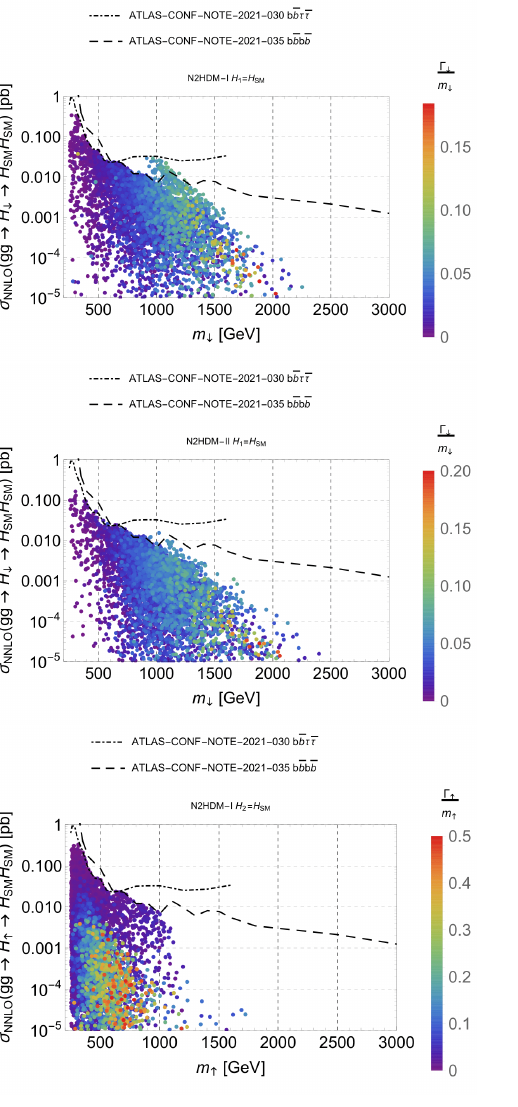
Figure 15 . Resonant production cross sections for the N2HDM points of figure 7 (lower) for N2HDM-I (upper) and N2HDM-II (middle) with H type 1 (left) and type 2 (right); all plots as a function of the resonantly produced Higgs boson. Color code: ratio of the total width of the resonant Higgs boson and its